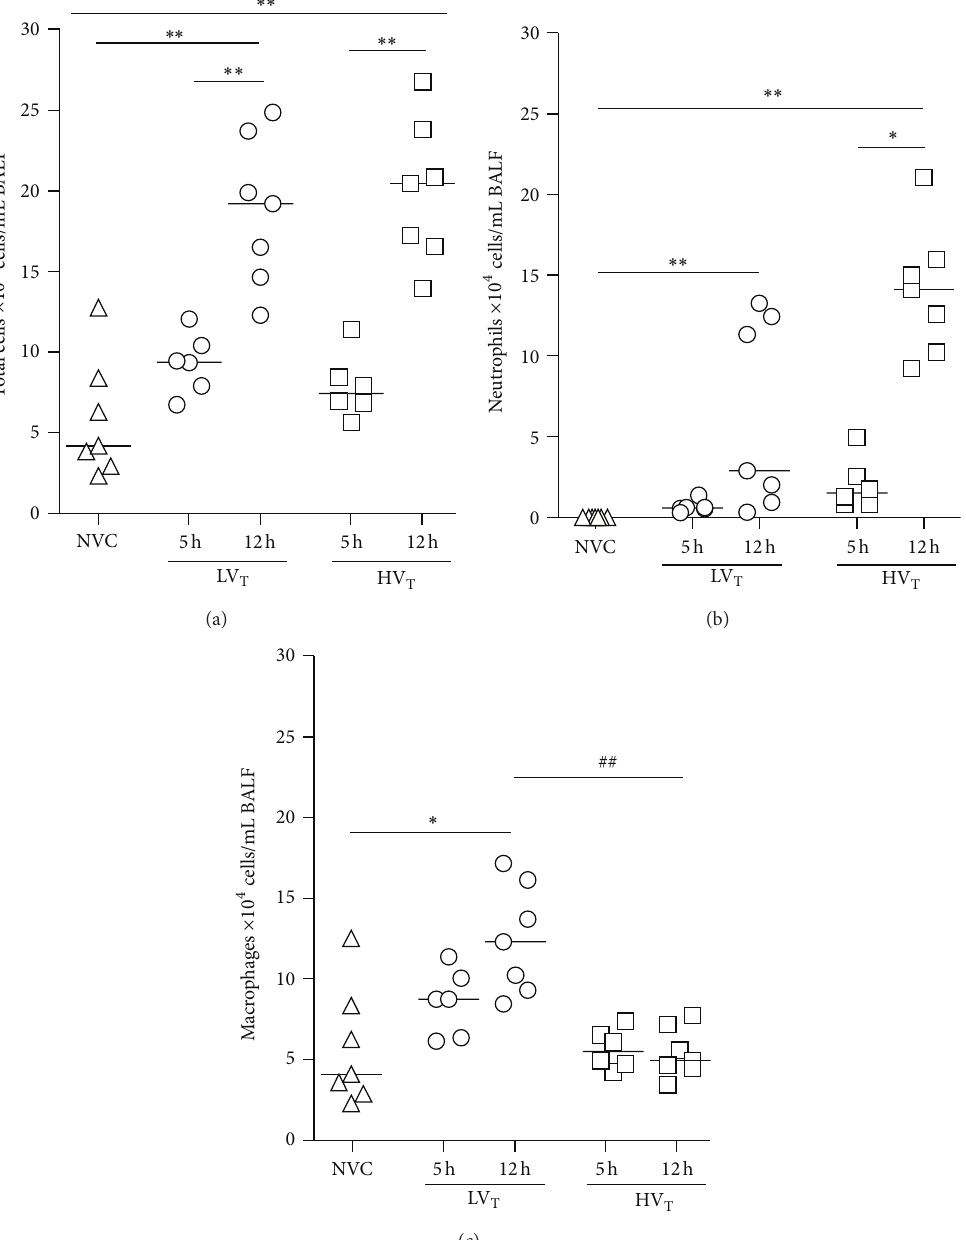
Figure 5: Cell infiltration. (a) Total cell counts were measured in bronchoalveolar lavage fluid (BALF). ((b)-(c)) Differential cell counts were performedonBALFcytospinpreparationstodetermineneutrophilandmacrophageinfiltration.Dataarepresentedasscatterplot(median)of 6–8 mice per group (triangle = NVC; circle = LV T ; square = HV T ). ∗ Illustrates primary statistical analysis ( ∗ 𝑃 < 0.05 , ∗∗ 𝑃 < 0.01 ); # illustrates secondary statistical analysis ( ## 𝑃 < 0.01 ). NVC = nonventilated controls; LV T , HV T = LV T /PEEP or HV T /ZEEP ventilator settings; 5h, 12h = 5 or 12 hours of